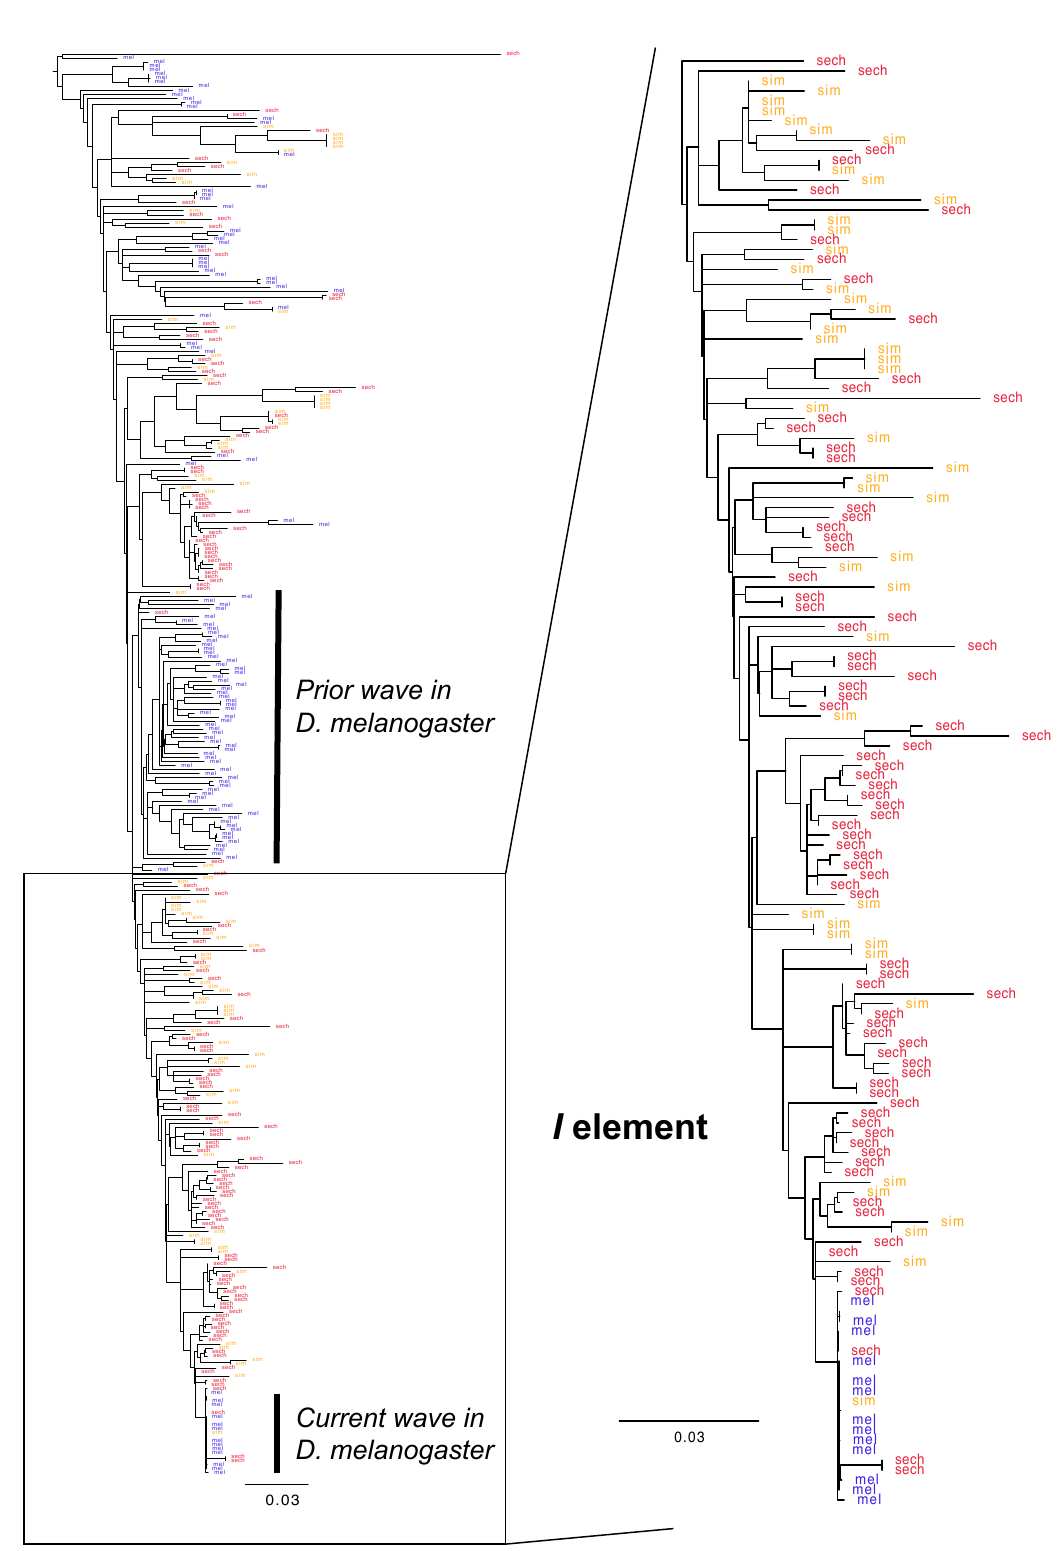
Figure 3. Phylogenetic analysis of I element fragments extracted from the genomes of D. melanogaster , D. simulans and D. sechellia . Alignments from BLAST output (E cuto ff − 100) were subjected to phylogenetic analysis with GARLI. Blue indicates D. melanogaster , red indicates D. sechellia and orange indicates D. simulans . A zoom-in is provided for further detail of recent dynamics. Like hobo , the I element shows evidence of a previous wave in D. melanogaster , as well as new proliferation derived from a lineage residing within D. simulans or D. sechellia